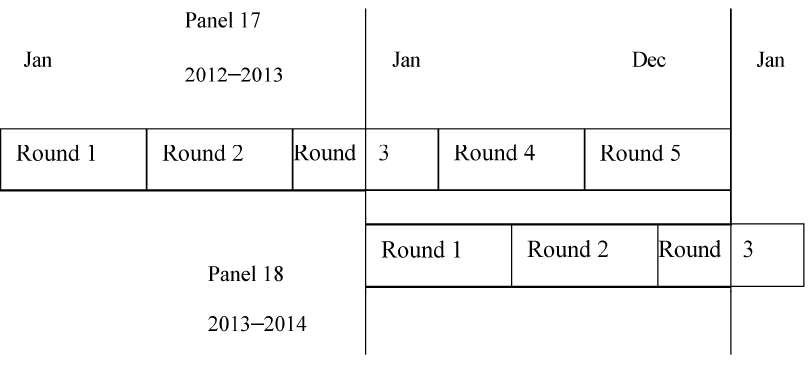
Figure 1. Adopted from MEPS AHRQ panel design